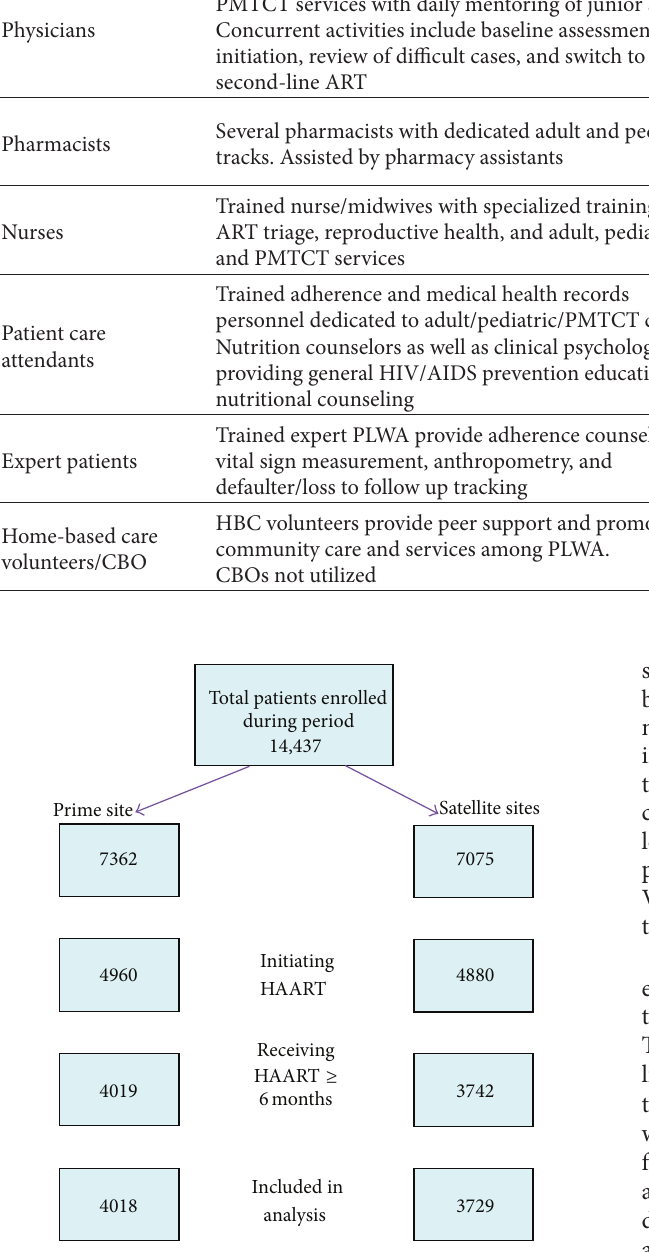
Figure 2: Flow chart of patients included in the study.